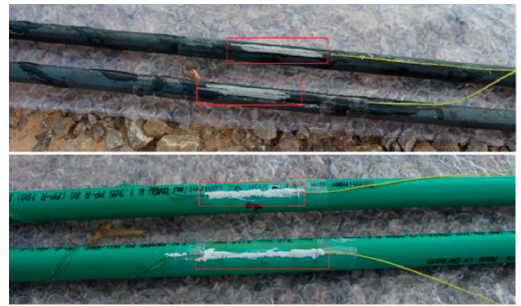
Figure 3. Protective epoxy resin layer for bare fiber.